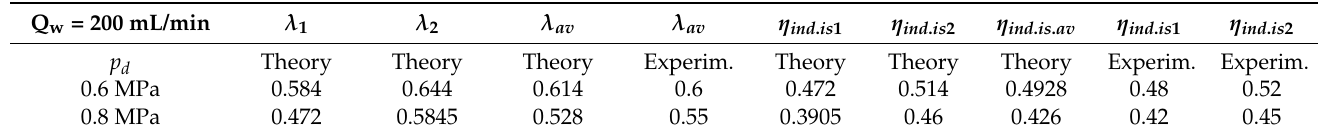
Table 2. Comparison of the main integral and consumption parameters of the machine under study at different gas discharge pressures.